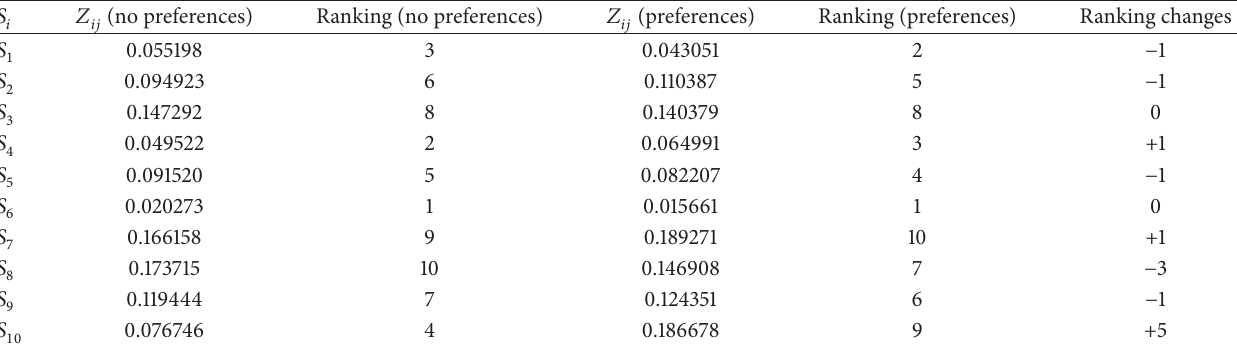
Table 5: Alternatives ranked either with, or without, consideration of